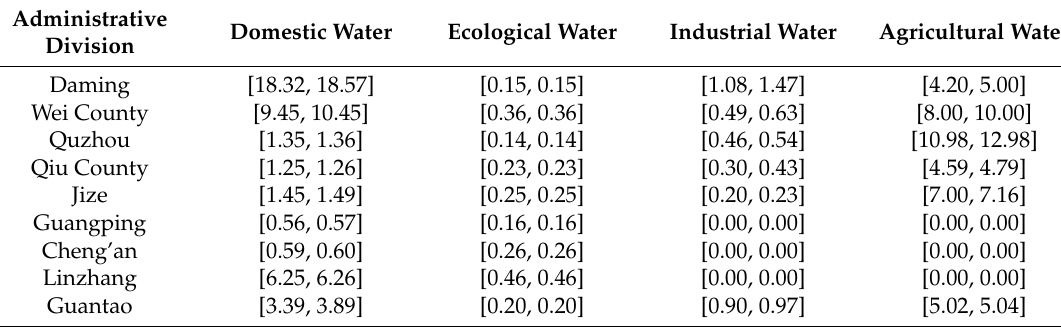
Table 7. Result of transferred water allocated to every user (10 6 m 3